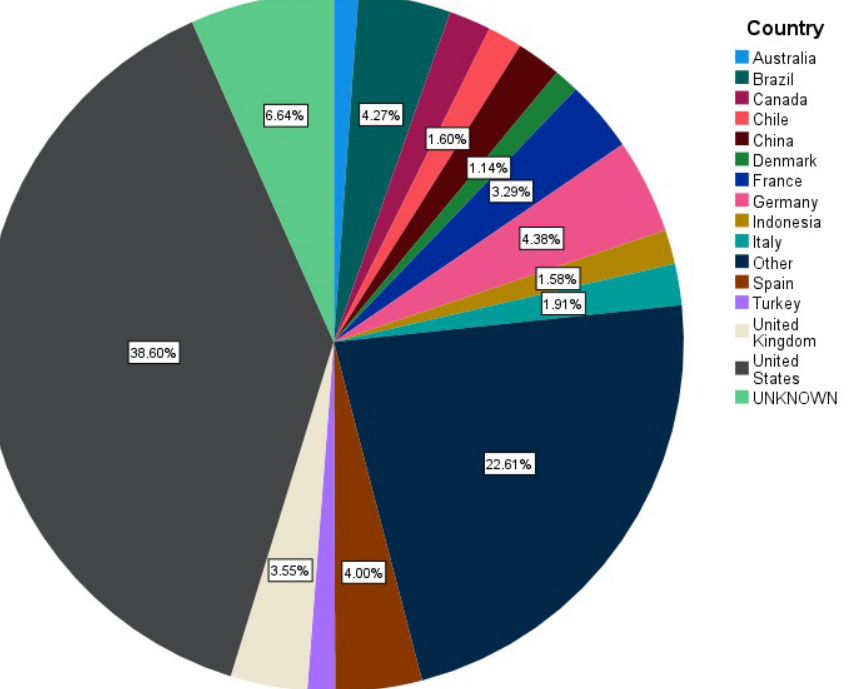
Figure 4. Percentage of the top defaced websites in multiple countries in 2010–2011